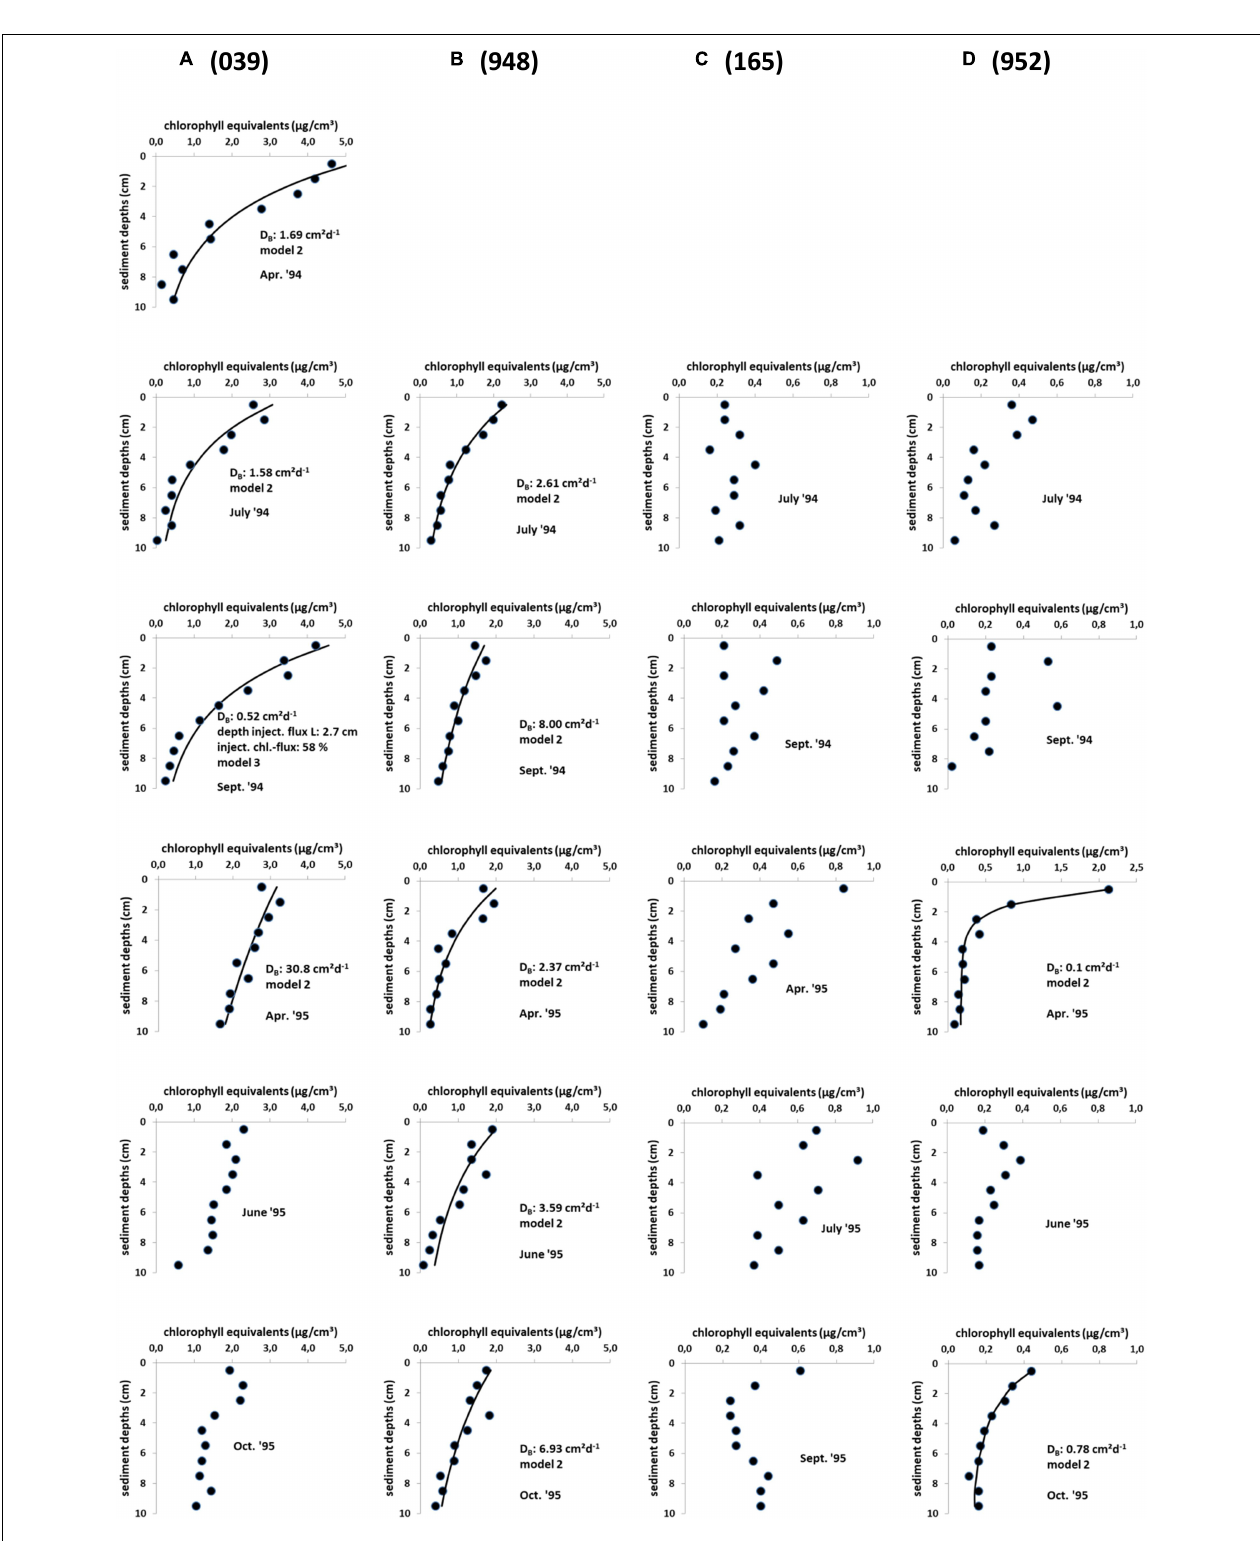
FIGURE 3 | (A–D) In situ chlorophyll equivalent concentration profiles (dots) in sediment cores of stations 039 (A) , 948 (B) , 165 (C) , and 952 (D) in the Pomeranian Bay with active fauna between April 1994 and October 1995. Solid lines indicate the simulations with the diffusion/non-local bioturbation models 2 and 3, which include bioturbative (diffusive) mixing only in model 2 or an additional non-local transport term of the pigment flux directly into a certain sediment depth L in model 3 (Soetaert et al., 1996).